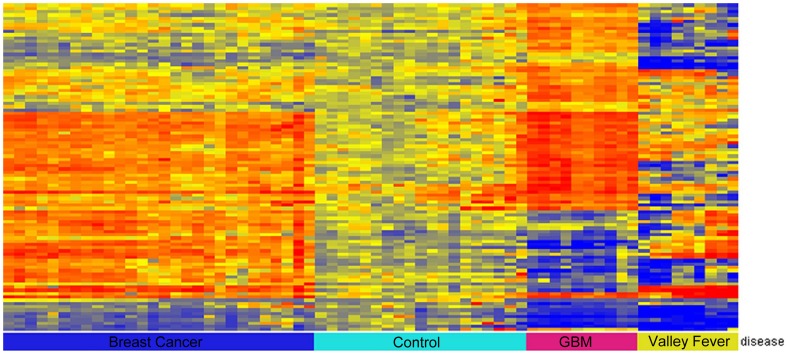
Classification across diseases.The heatmap presented here distinguishes 4 different diseases using 70 peptides identified as the most significant using a 1-way ANOVA across the 27 breast cancer patients, 19 healthy controls, 10 Gliobastoma multiformae patients, and 9 Valley Fever patients. Classification accuracy was 100% using both linear discriminant analysis and Support Vector Machines and leave one out cross-validation.